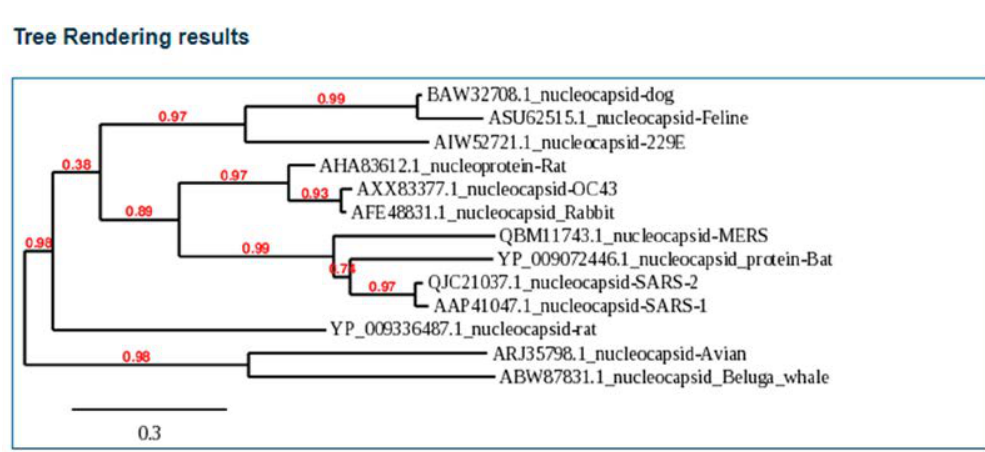
Fig. 2. Phylogenetic Tree analysis of SARS-CoV-2 and other Coronaviruses